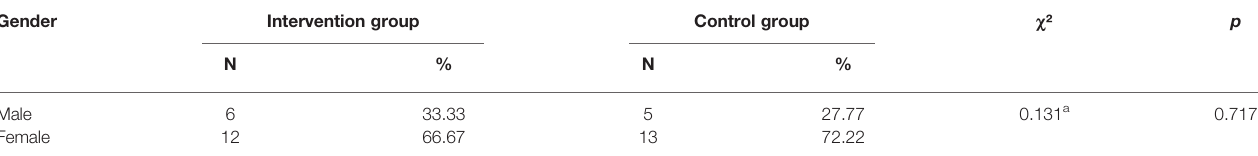
TABLE 2 | Comparison of gender between the intervention and the control group (n = 36).